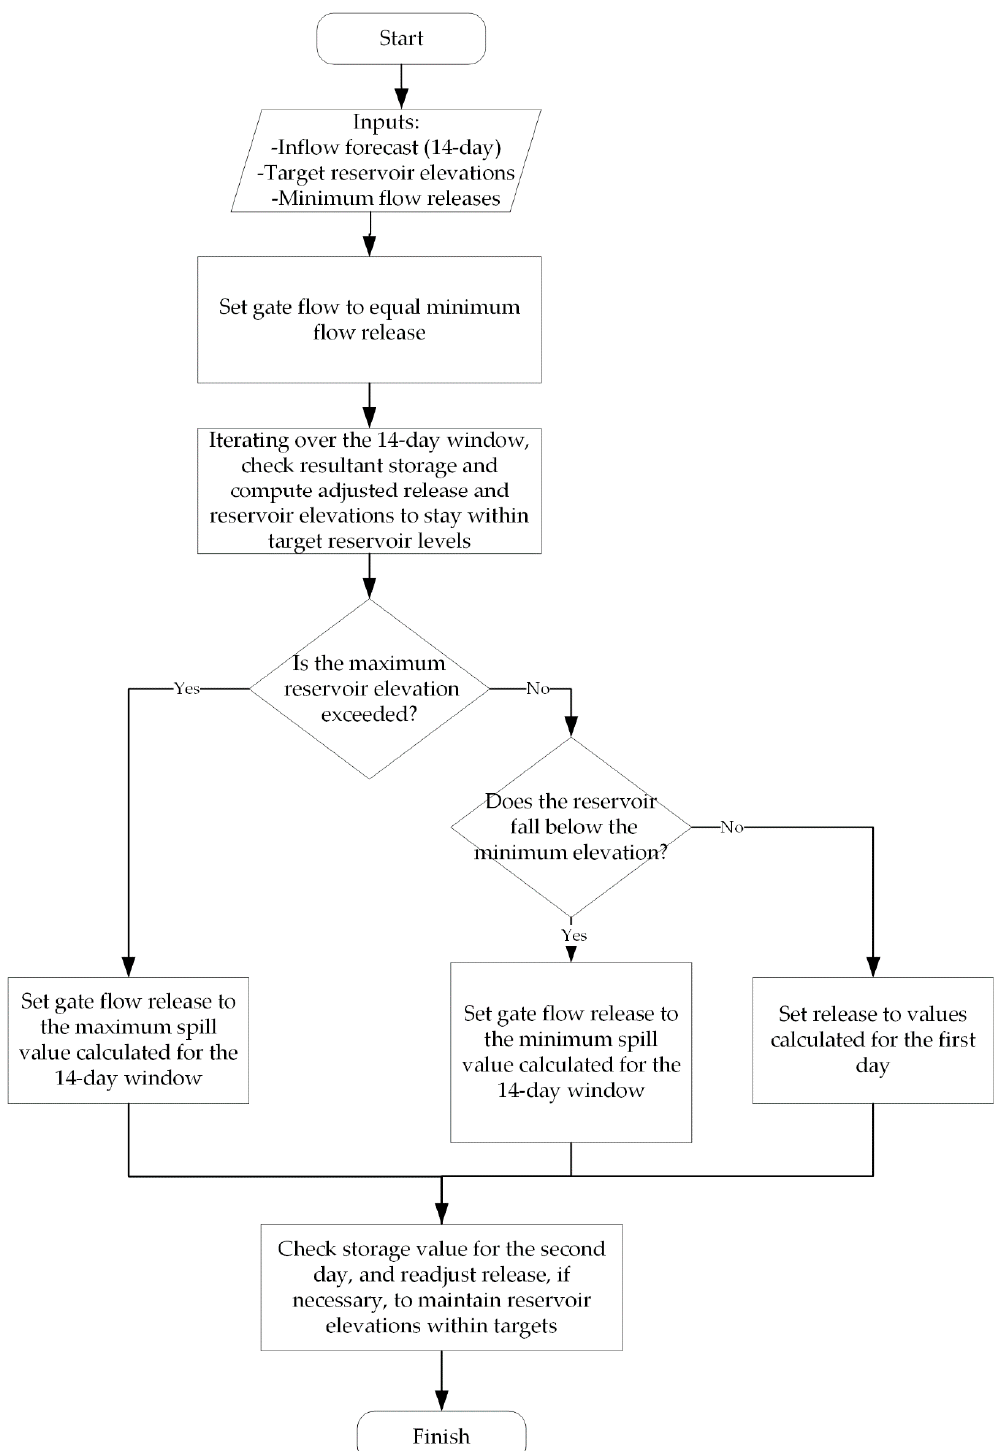
Figure 5. Simple operations planning algorithm.